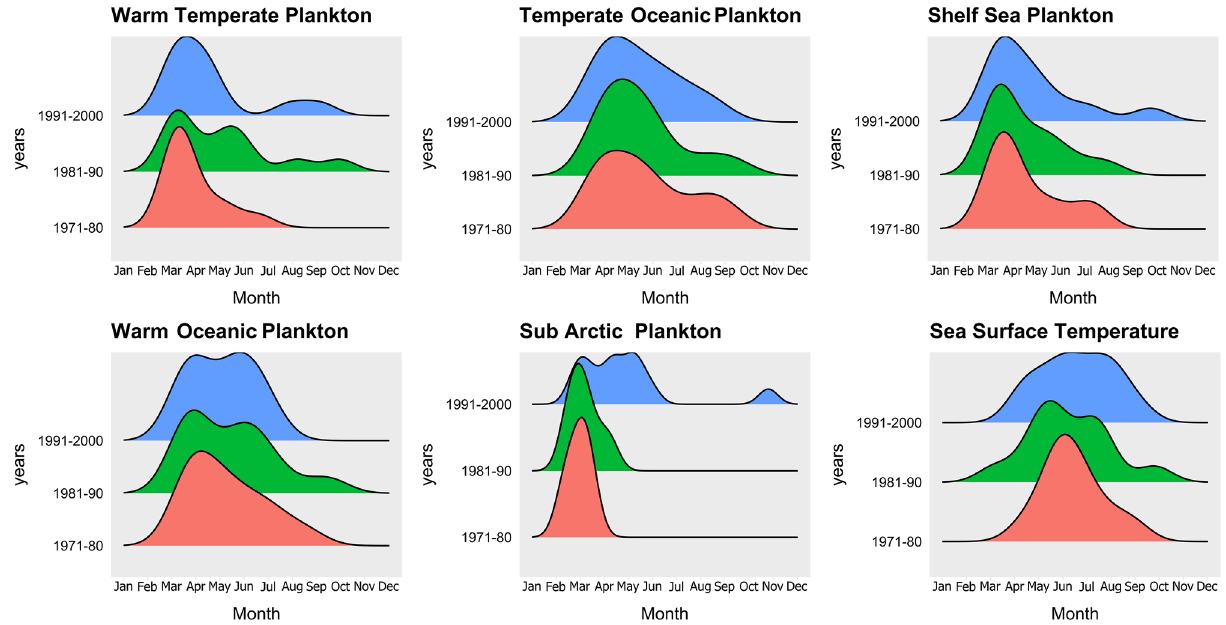
Figure 4. Historic Plankton group abundances (from CPR data) and sea surface temperature (from UK Meteorological Office). The three time periods are shown in different colours: Peach 1971–1980; Green 1981– 1990, and Blue 1991–2000. The x-axis is the month of the year, and the y-axis shows the relative zooplankton abundance (scaled relative to each groups maximum) for each time period. This relative scaling is to enable clear comparisons of relative abundance between groups for each biogeographical zooplankton group over the three decades.